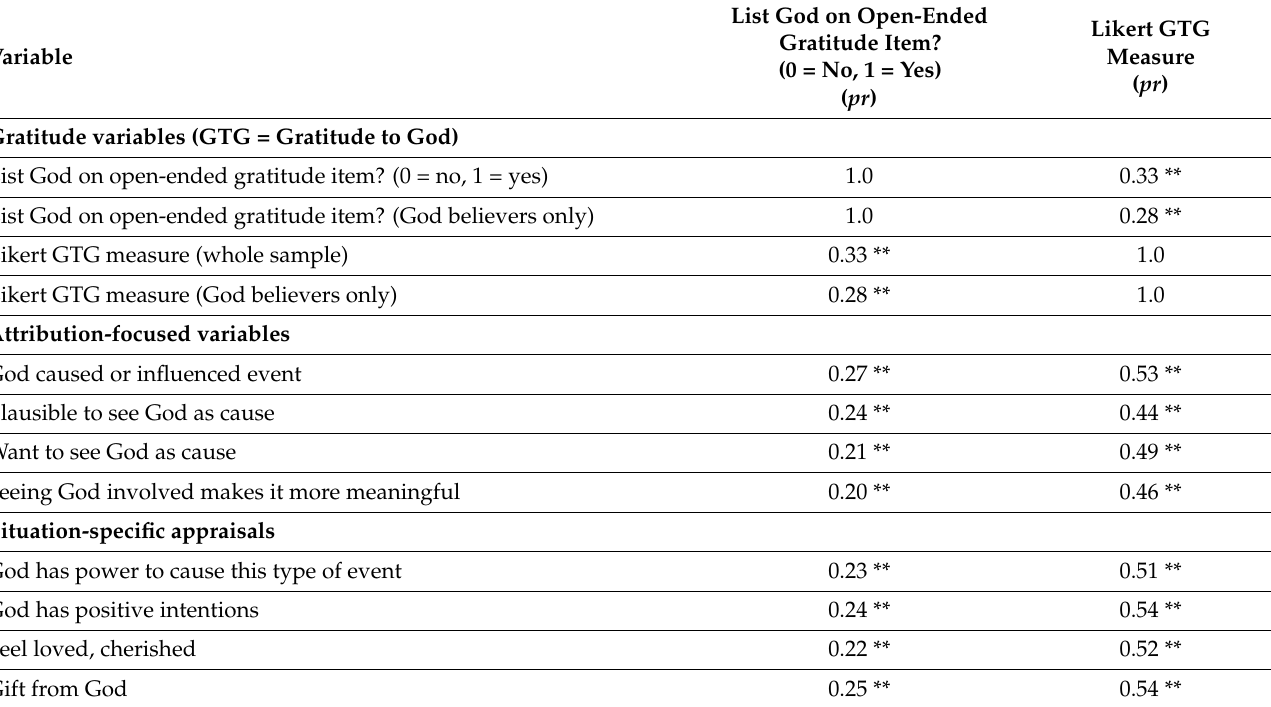
Table 5. Partial Correlations between Key Study Variables and Situational GTG (Controlling for Priming Condition Using Dummy